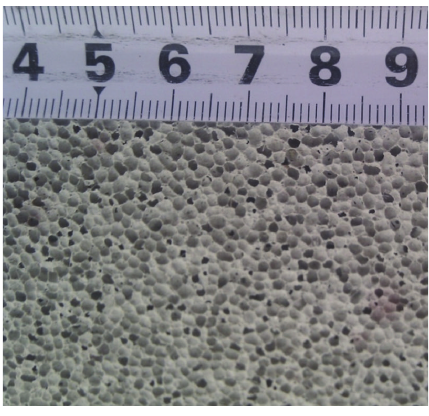
Figure 2: The pore structure of FC. Figure 3: The influence of fly ash content on the compressive strength of FC.